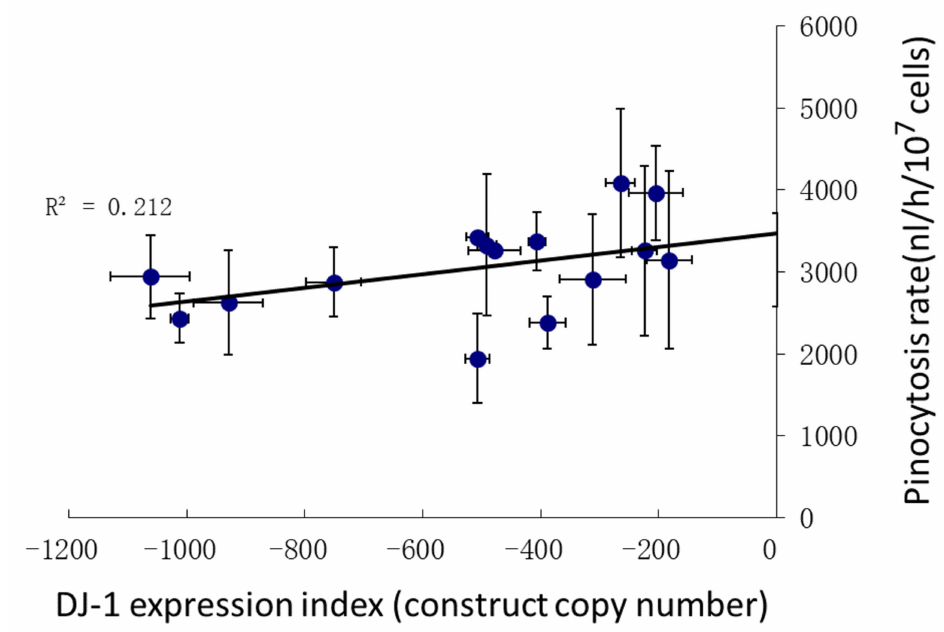
Figure 5. Pinocytosis by DJ-1 antisense transformants under oxidative stress. The pinocytosis rates of the DJ-1 antisense transformants showed a slight decrease as the copy numbers of DJ-1 antisense- inhibition construct (pPROF688) increased compared with AX2, but this was not significant ( p = 0.073) (F test, n = 16). R 2 represents the fraction of the variance that was attributable to the regression relationship. Error bars are standard errors of the mean from 3 independent